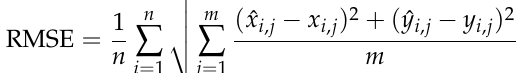
(cid:12) (cid:16) (cid:12) (cid:12)(cid:98) θ S ∗∗ , ∆ S (cid:48)(cid:48) , (cid:98) D (cid:48)(cid:48) R ] = [ 1,0.5 ] and [ ∆ x (cid:48)(cid:48) , ∆ y (cid:48) 1 1